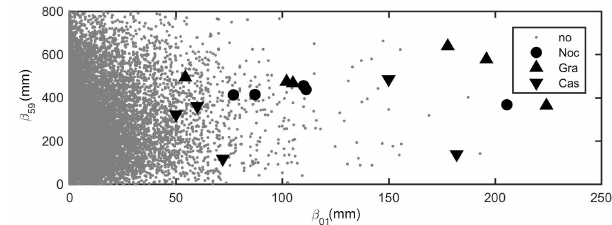
Figure 6. Pairs of cumulative rainfall thresholds β 01 and β 59 recorded daily in the period 1960–2015, with occurrence (by site) or non-occurrence of landslide events.